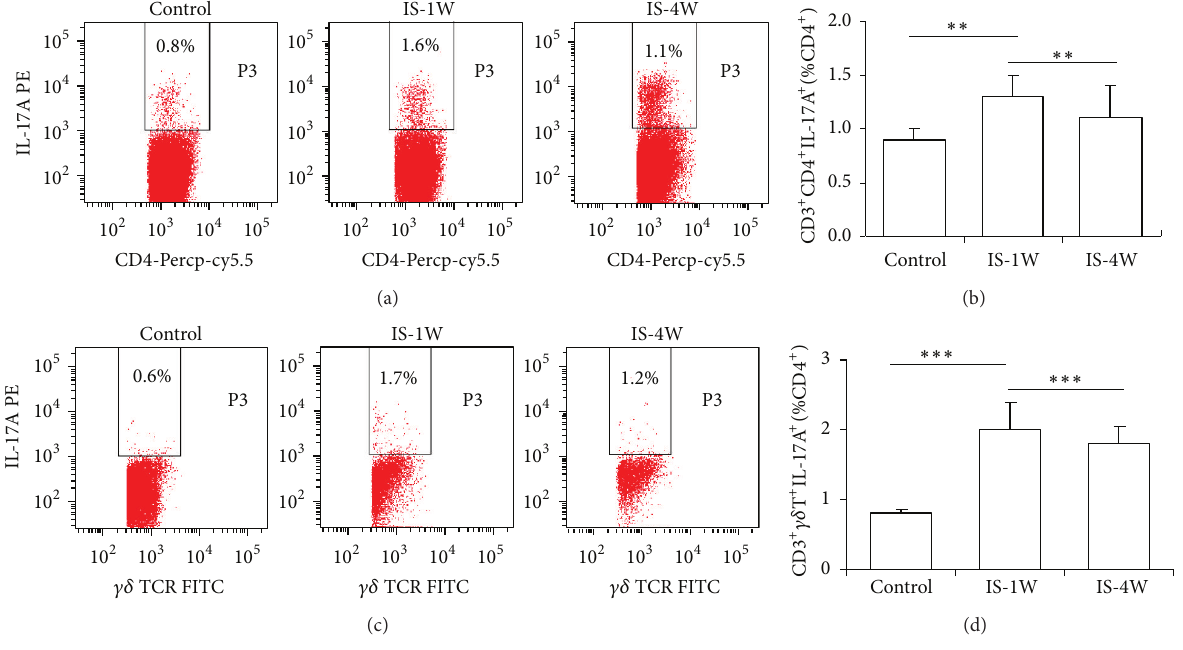
Figure 2: The proportion of IL-17A-producing cells was increased in IS patients. (a) Representative results from the FCM analysis of CD3 + CD4 + IL-17A + (Th17) cells among the total CD4 + T cell population in IS patients compared with controls. (b) The statistical analysis of the Th17 proportions in 30 control subjects and 50 IS patients at 7 and 28 days after stroke. (c) Representative results from the FCM analysis of inflammatory cells obtained from control subjects and IS patients. The percentage of IL-17A + CD3 + 𝛾𝛿 + T cells among the total CD4 + T cell population is indicated. (d) Statistical analysis of the results from the FCM analysis of the proportions of IL-17A + CD3 + 𝛾𝛿 + T cells in the blood samples obtained from the 30 control subjects and 50 IS patients at 7 and 28 days after stroke. ∗∗ 𝑃 < 0.01 and ∗∗∗ 𝑃 < 0.001 , compared with the